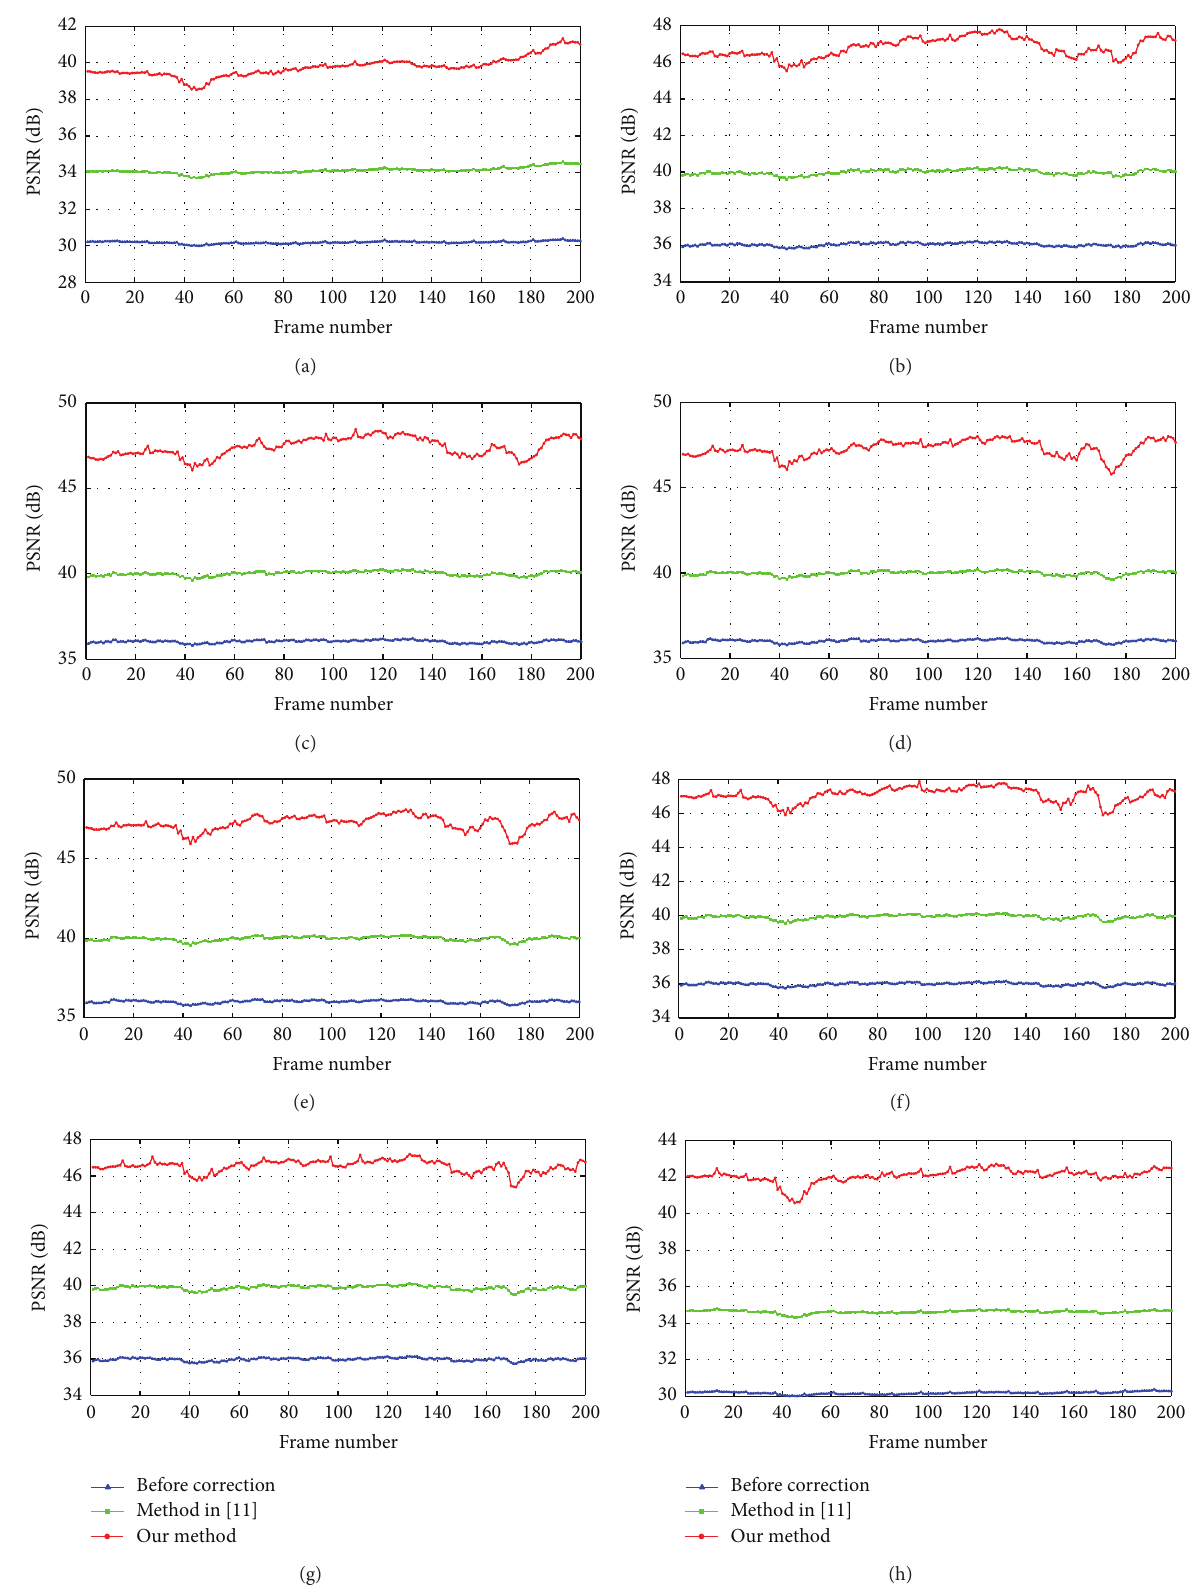
Figure 6: PSNR versus frames for each view in “Lotus.” (a) PSNR of view 1 in “Lotus.” (b) PSNR of view 2 in “Lotus.” (c) PSNR of view 3 in “Lotus.” (d) PSNR of view 4 in “Lotus.” (e) PSNR of view 5 in “Lotus.” (f) PSNR of view 6 in “Lotus.” (g) PSNR of view 7 in “Lotus.” (h) PSNR of view 8 in